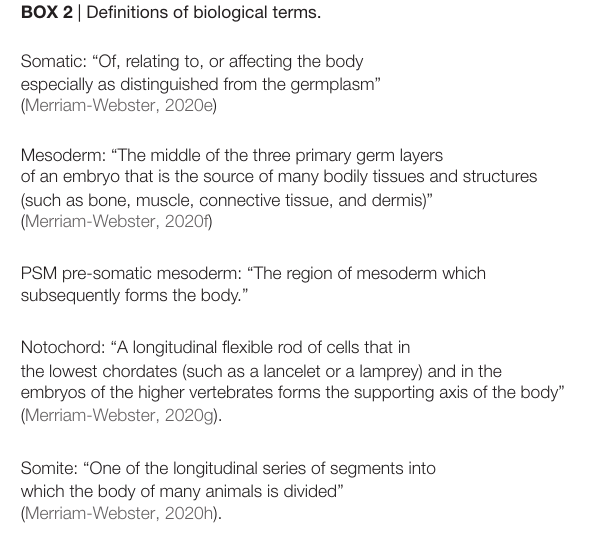
For further details see section